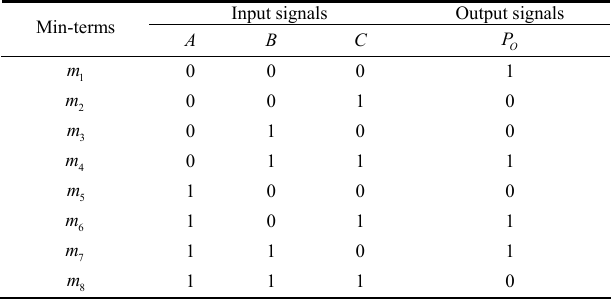
Table 2 Truth table of odd parity generator.